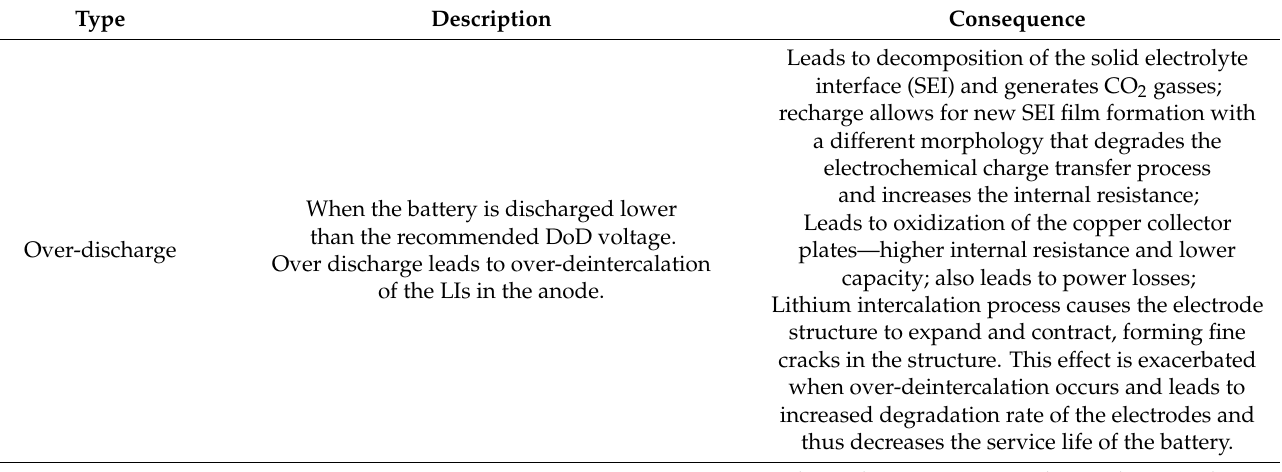
Table 7. Causes of degradation in lithium-ion batteries, adapted from